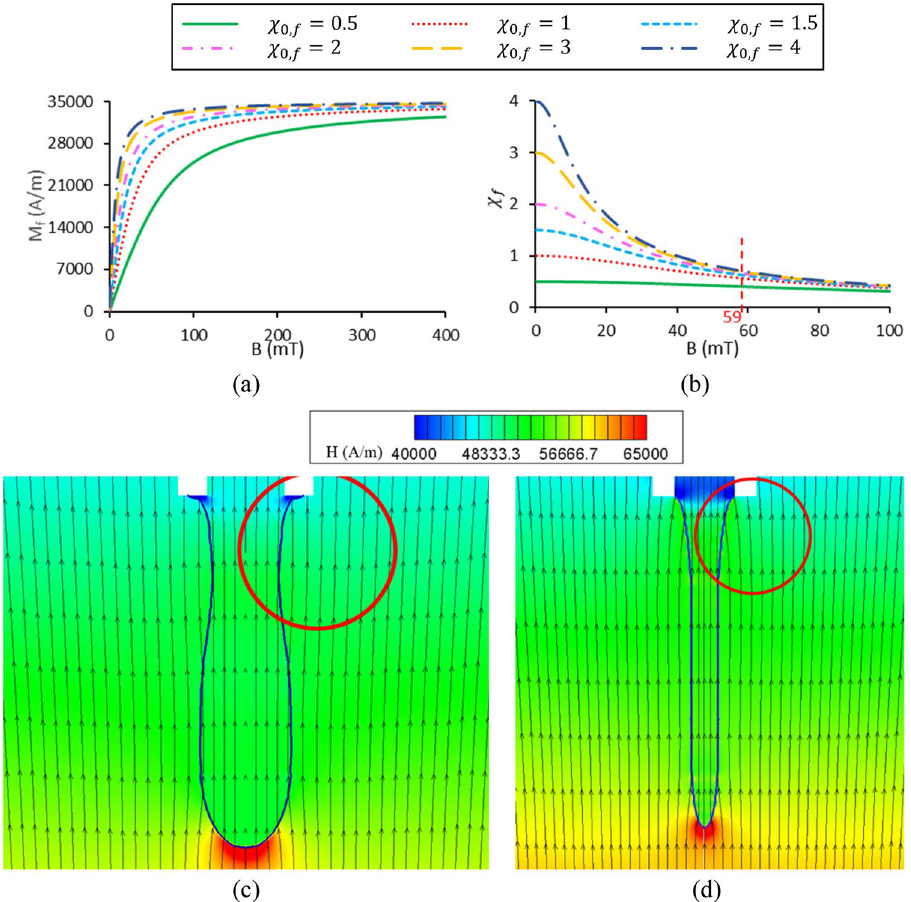
Figure 18. Variations of ( a ) ferrofluid magnetization and ( b ) its magnetic susceptibility in terms of magnetic flux density for various initial magnetic susceptibilities and dimensionless saturation magnetization equal to 7.3. The contours of magnetic field strength and magnetic field lines are obtained numerically for initial magnetic susceptibilities of ( a ) 0.5 and ( b )